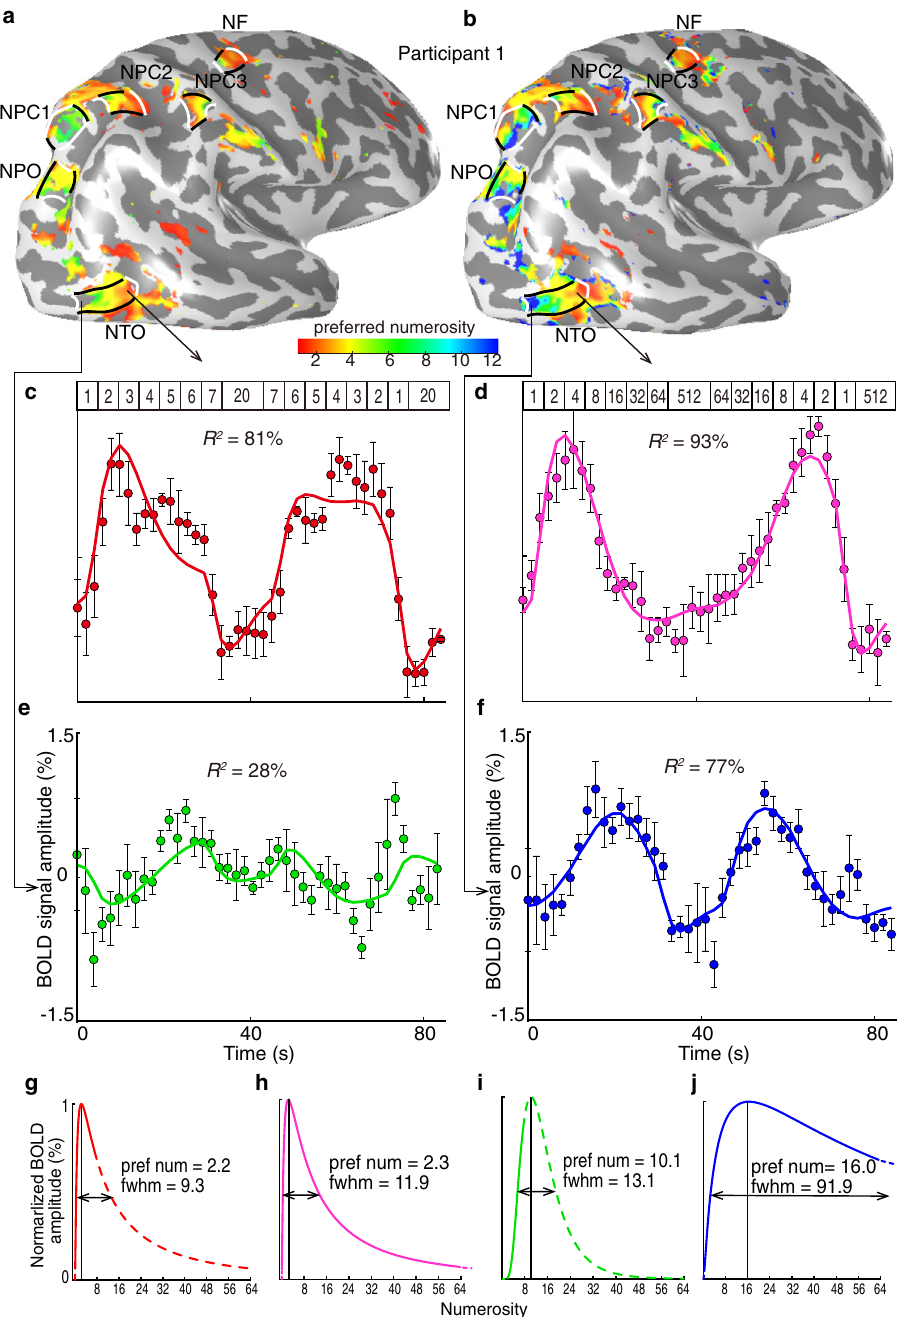
Fig. 1 Neural population responses to small and large numerosities. a , b Cortical surface rendering of the right hemisphere shows a similar network of numerosity maps in both presented ranges. Preferred numerosities of cortical recording sites, estimated from responses to the small range ( a ) and the large range ( b ) for recording sites with over 30% of variance explained by the neural response model. Black lines outline the lateral borders of individual numerosity maps. The borders denoting the lowest and the highest preferred numerosities in each map are marked by white lines. An example fMRI recording site in anterior NTO shows different fMRI time courses (dots) for small ( c ) and large ( d ) numerosity ranges. Both time courses are similarly well captured by the predictions (coloured lines) of similar neural response models. Dots represent mean response amplitudes; error bars represent the standard errors over repeated measurements ( n = 4). The presented numerosities are indicated at the top of the graph. e , f An example fMRI recording site in posterior NTO shows a higher preferred numerosity. This response does not reach a maximum in the small numerosity range ( e ). Dots represent mean response amplitudes; error bars represent the standard errors over repeated measurements ( n = 4). g , h For both numerosity ranges, the anterior NTO site ’ s response is predicted by similar neural response models. i , j For the large numerosity range, posterior NTO site ’ s response is well predicted by a neural response model ( j ). However, this sites ’ preferred numerosity is above the small numerosity range, so it could not be determined accurately ( i ), produces only low-amplitude responses and yields poorer model fi ts ( e ) with this range. Preferred numerosity is indicated by the highest response amplitude in the neural model, and tuning width is indicated by the full width at half maximum (FWHM). The neural response model within the presented range is shown with solid lines, outside the range with dashed